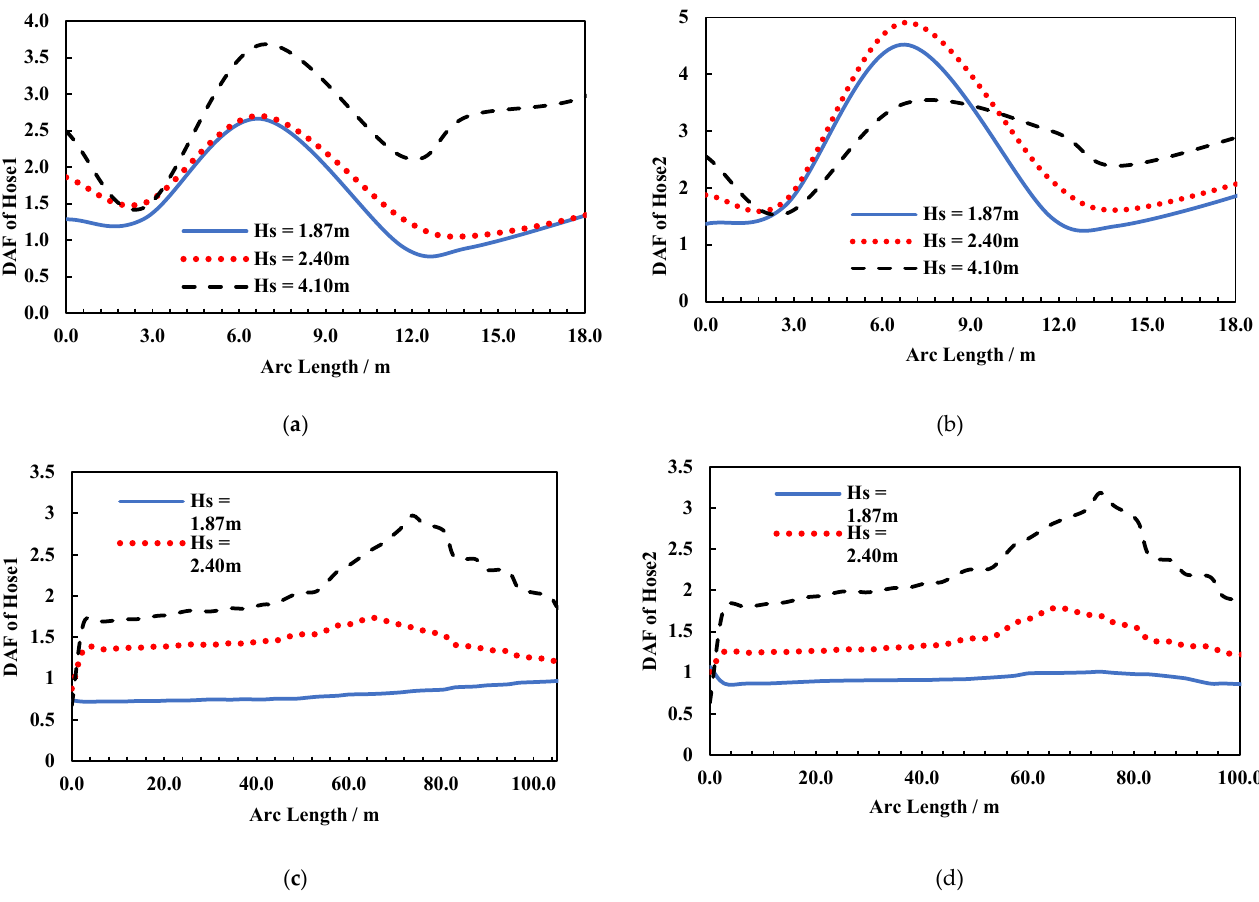
Figure 26. Results on DAF Hose for different environmental cases . Figures ( a , c ) are when the hoses have RAO loads, while Figures ( b , d ) are when the hoses are without RAO loads for the submarine hoses in Lazy-S config. ( a ) Bending Moment DAF Hose for Hose1. ( b ) Bending Moment DAF Hose for Hose2. ( c ) Effective Tension DAF Hose for Hose1. ( d ) Effective Tension DAF Hose for Hose2.